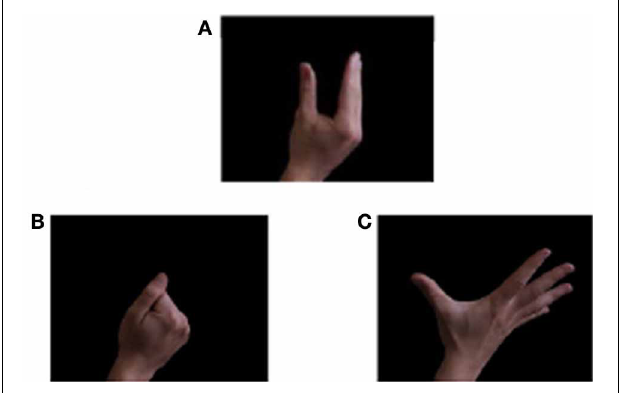
FIGURE 1 | Stimuli used for the experimental paradigm. Hand postures: (A) Neutral hand posture; (B) Closed hand posture; (C) Open hand posture. Reprinted from Leighton et al.